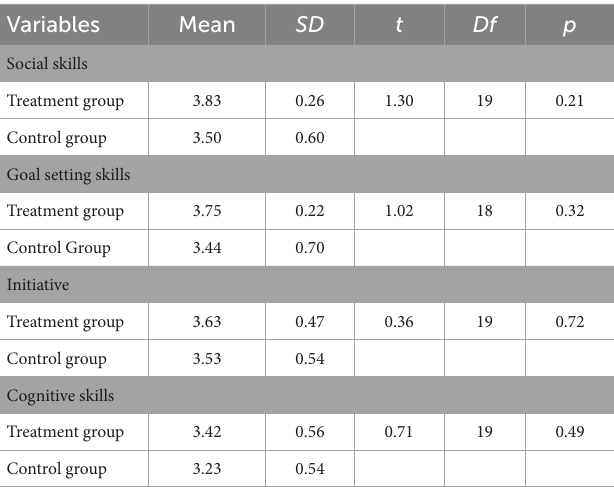
TABLE 3 Correlation matrix on the relationship between physical activities and entrepreneurship tendencies.